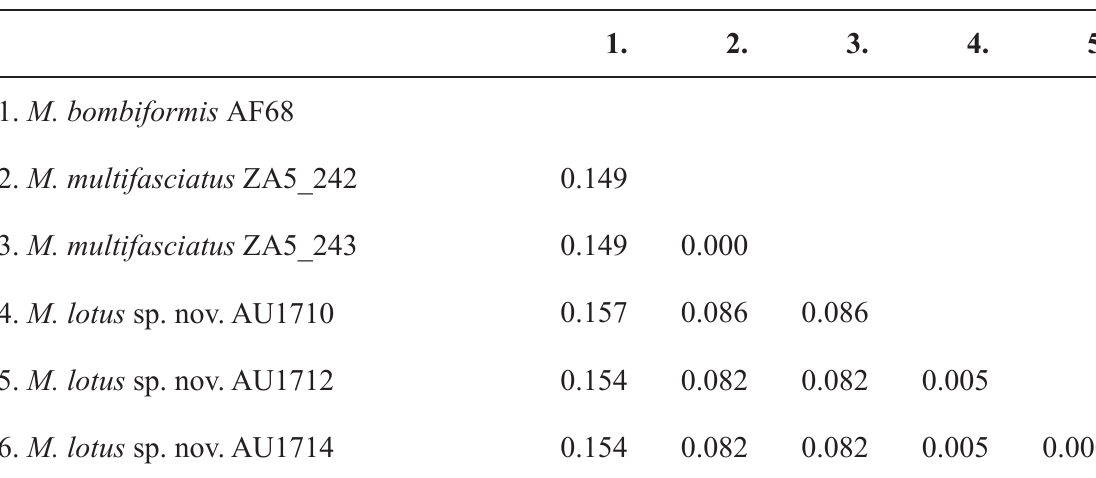
Table 1. Uncorrected pairwise distances of COI gene sequences among specimens of species in the M. bombiformis species group.